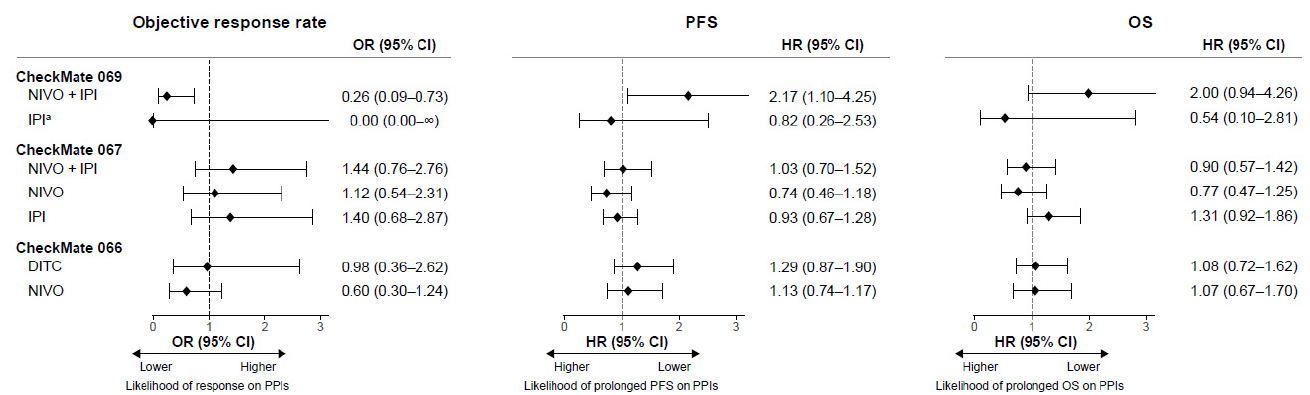
Figure 1. Association between baseline PPI use and efficacy in CheckMate 066, 067, and 069. Forest plot of ORs for objective response rate and HRs for OS and PFS derived from multivariable models. Error bars indicate 95% CIs. Point estimates and CIs for the association between PPI use (yes vs. no) and each outcome for all covariates included in the multivariable models are shown in Supplementary Tables S1–S3. a The logistic regression model for the objective response rate failed to converge in this group. CI: confidence interval; DITC: dacarbazine; HR: hazard ratio; IPI: ipilimumab; NIVO: nivolumab; OR: odds ratio; OS: overall survival; PFS: progression-free survival; PPI: proton pump inhibitor.